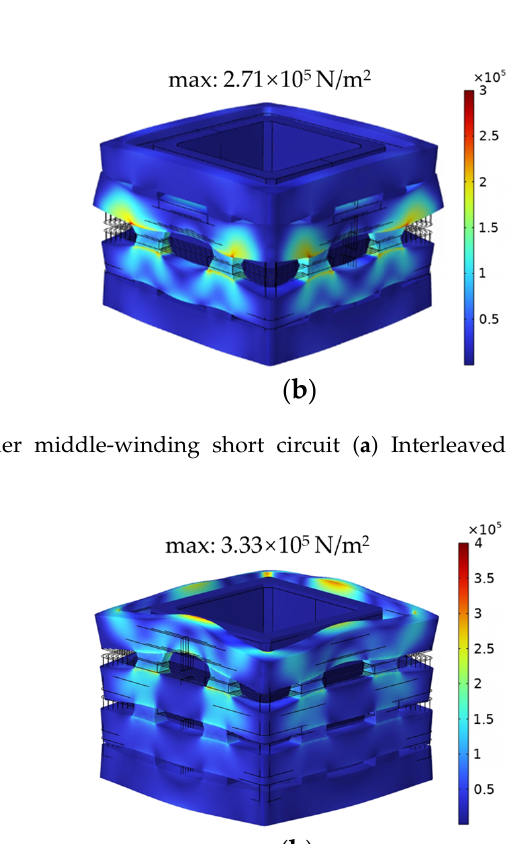
Figure 12. Stress distribution under normal condition ( a ) Interleaved winding; ( b ) Continuous winding.